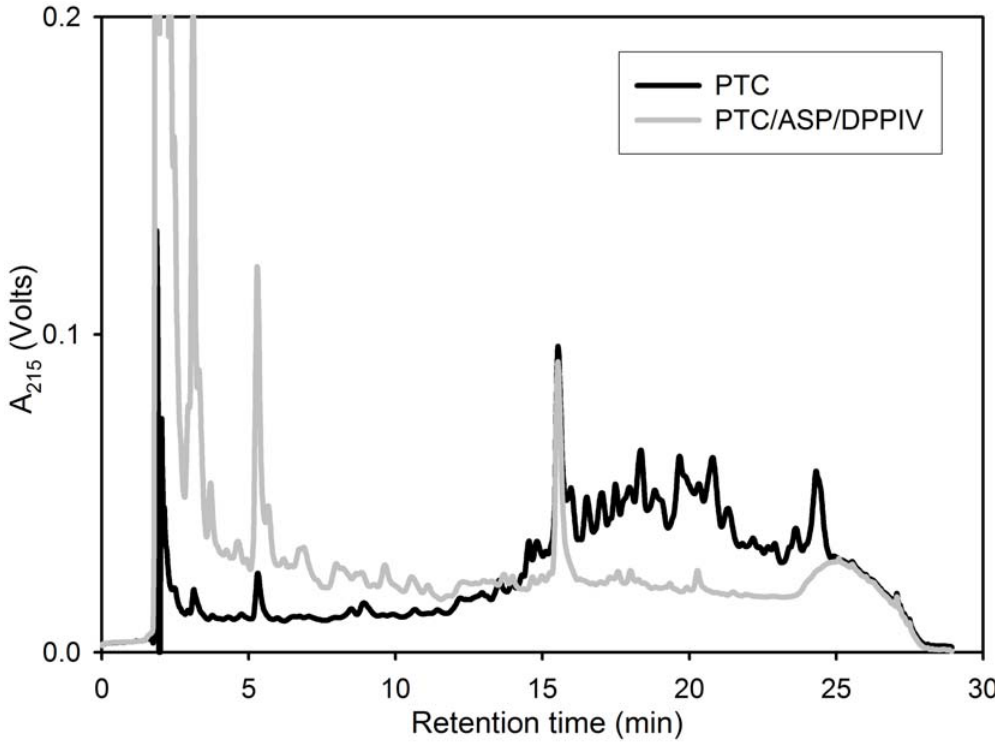
Figure 6. Effect of aspergillopepsin (ASP) and dipeptidyl peptidase IV (DPPIV) on the proteolysis of baked gluten in whole wheat bread under simulated gastric and duodenal conditions. The reverse phase HPLC traces show the residual peptide content after whole wheat bread was incubated with pepsin (0.6 mg/ml) under simulated gastric conditions, followed by trypsin (0.375 mg/ml) and chymotrypsin (0.375 mg/ml) under simulated duodenal conditions (PTC) or PTC + ASP (0.35 mg/ml) + DPPIV (0.7 mg/ml). The peak at 15 min corresponds to an internal standard (TAME). For experimental details, see text.